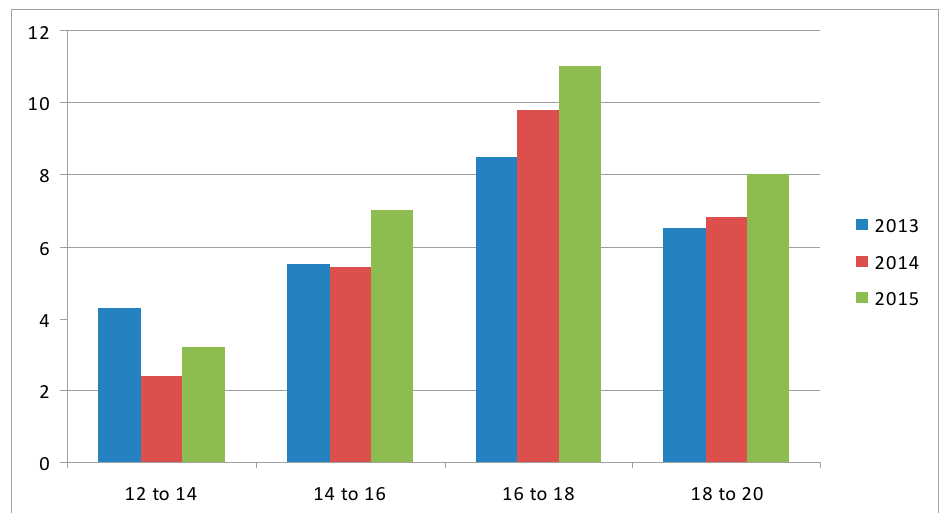
Figure 8. Time band/TV Auditel Share.